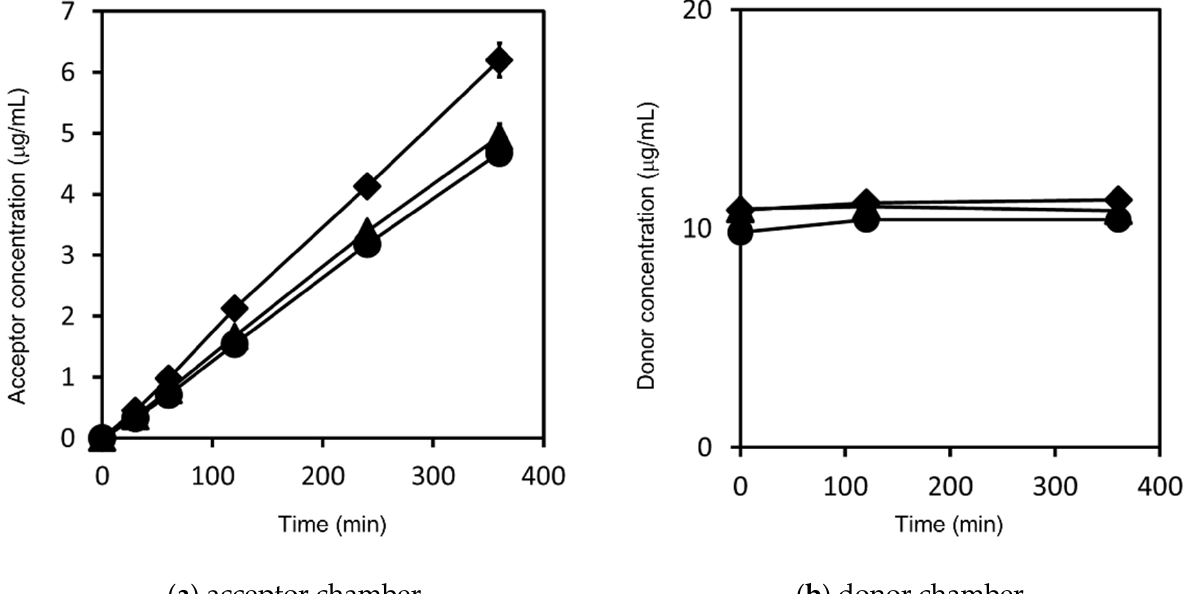
Figure 5. Griseofulvin concentration–time profiles in: ( a ) the acceptor chamber; ( b ) the donor cham- ber. The results represent the average griseofulvin concentration ± SD ( n = 3) for nanosuspension griseofulvin ( ◆ ), S-microparticle griseofulvin ( ▲ ) and L-microparticle griseofulvin ( ● ).